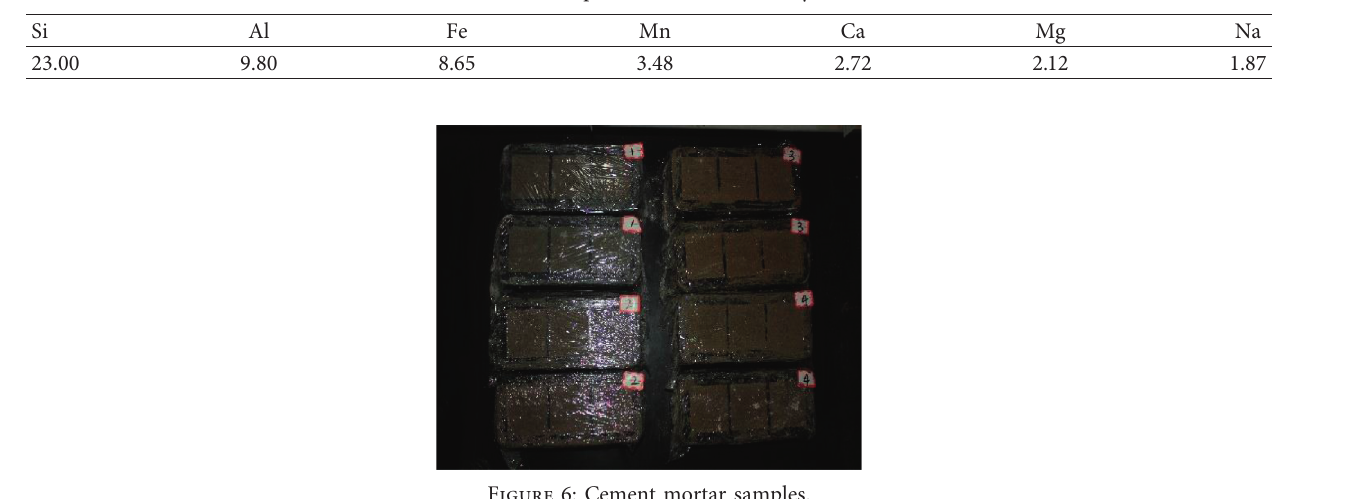
Table 2: Main component element of sandy soil (%).